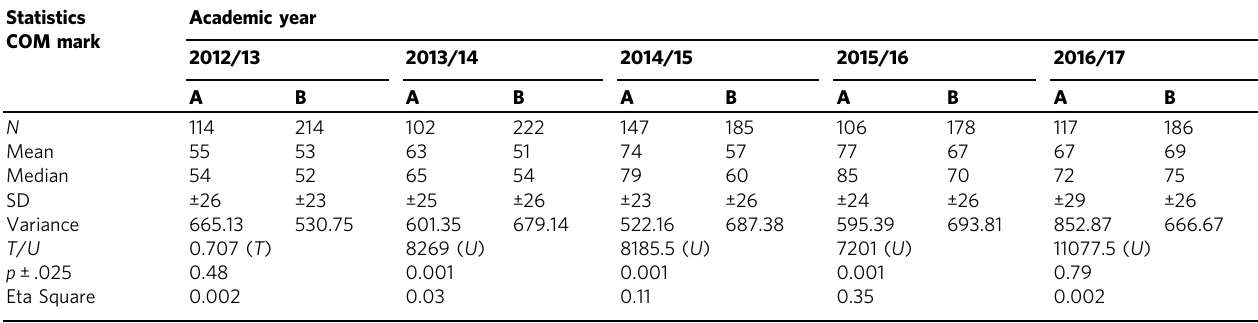
Table 1 Statistics on COM mark, comparing students ’ marks between two locations (A and B) during each of the academic years 2012 to